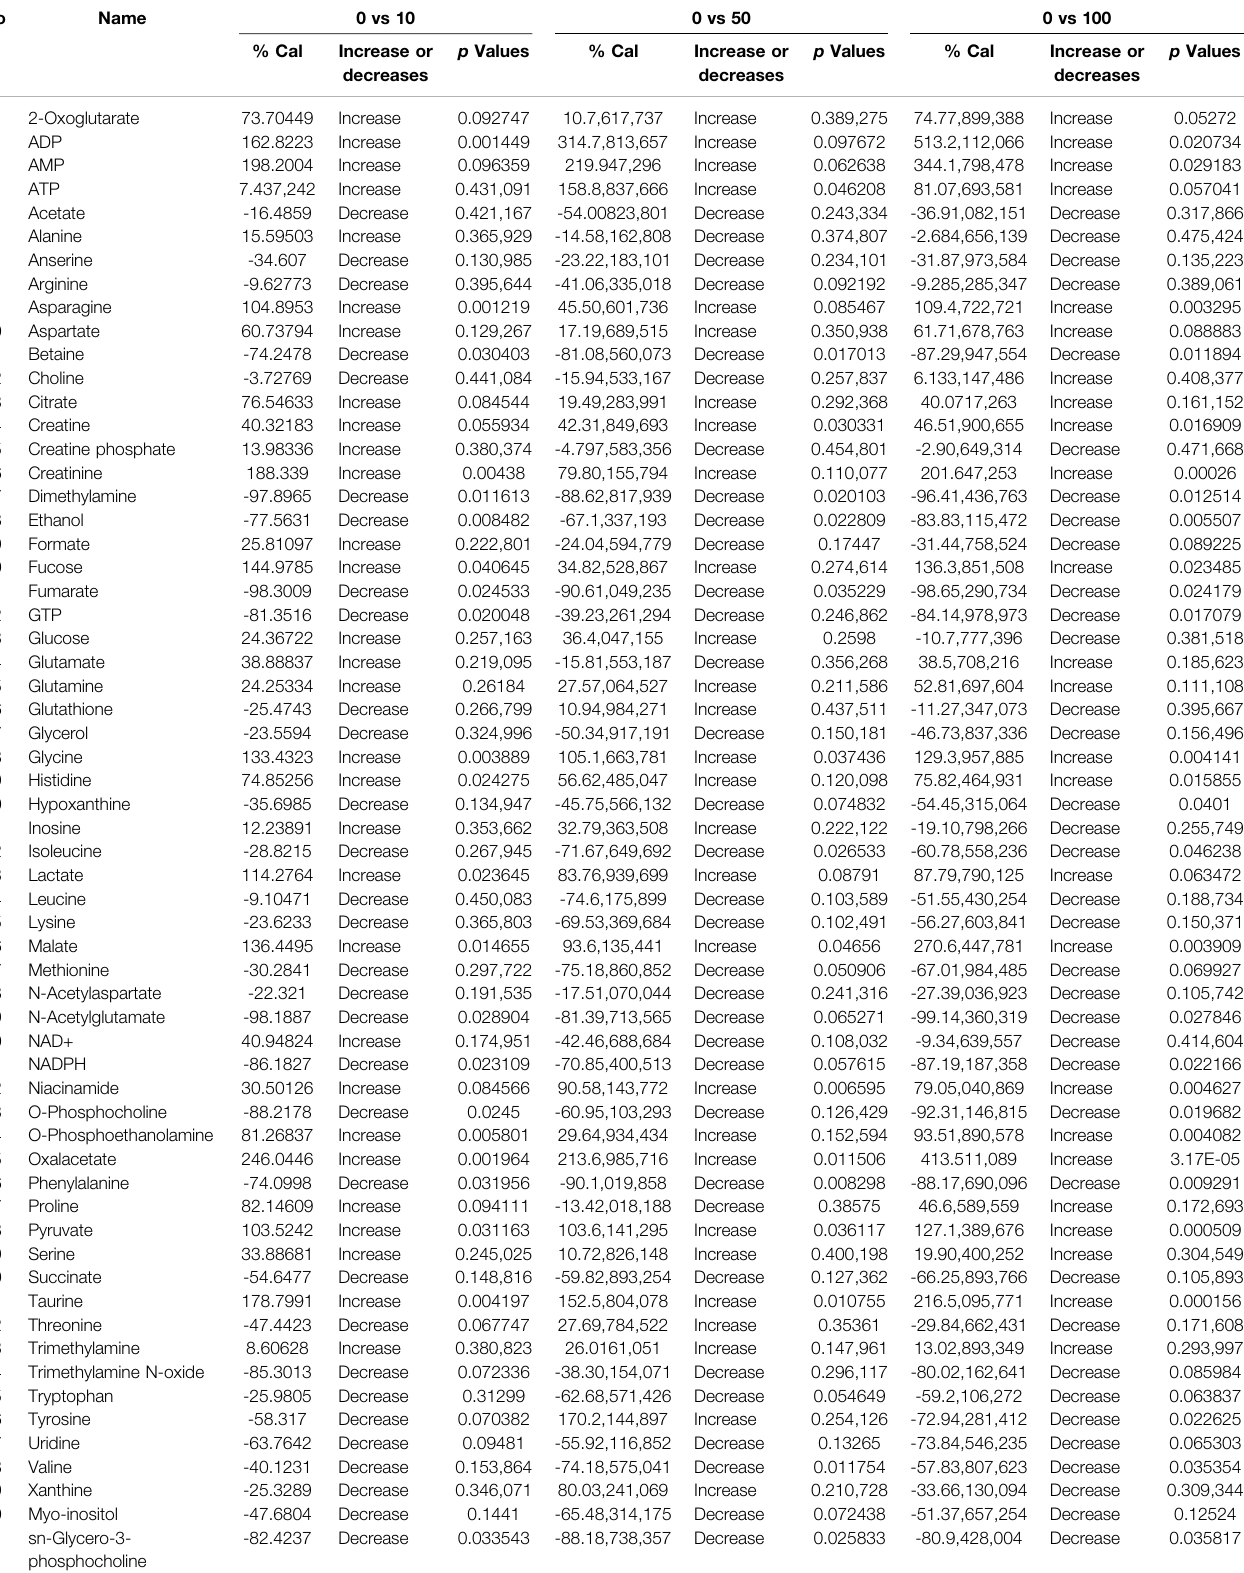
TABLE 1 | The description of the quanti fi ed metabolites in metabolomic fi ngerprint associated with decompensatory state in SWCNT with three